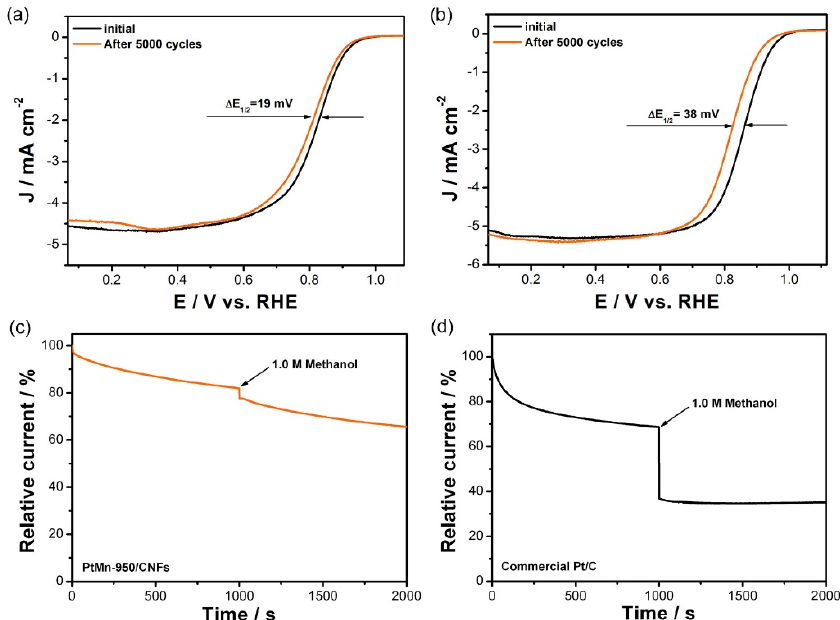
Figure 6. Comparison of ORR polarization curves for ( a ) PtMn-950 / CNFs and ( b ) a commercial Pt / C catalyst before and after 5000 cycles in O 2 -saturated 0.10 M KOH solution (rotation rate: 1600 rpm; sweep rate: 10 mV s − 1 ). Current-time chronoamperometic responses for ( c ) PtMn-950 / CNFs and ( d ) a commercial Pt / C catalyst in O 2 -saturated 0.10 M KOH followed by adding 1.0 M methanol at 1000 s (rotation rate: 1600 rpm; applied potential: 0.82 V).